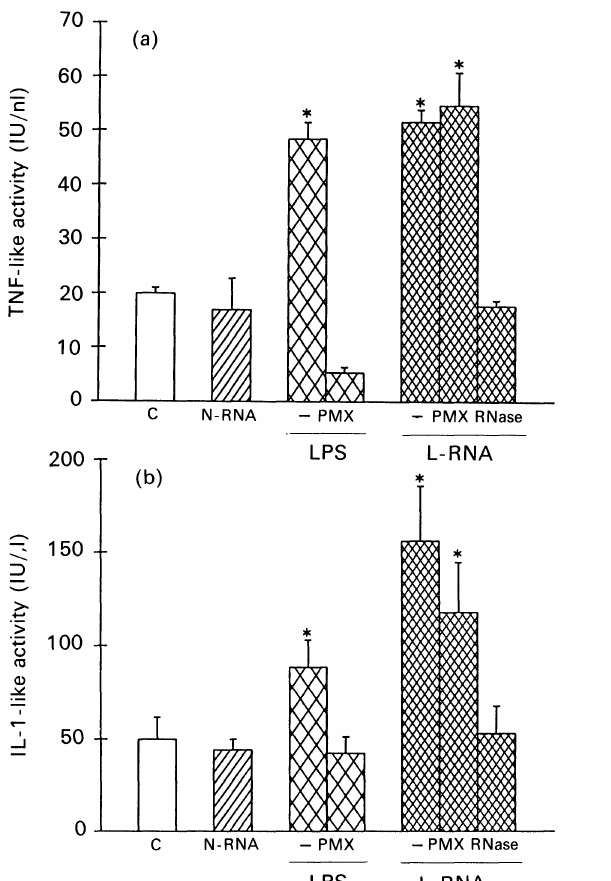
FIG. 1. The effect of L-RNA and N-RNA on the release of TNF-a and IL-1 by resident macrophages. Macrophage monolayers were incubated with N-RNA (25/l/ml), L-RNA (25/g/ml), LPS (10/g/ml) or RPMI medium alone (C) for 6 h. The L-RNA was also incubated with RNase (2/g of enzyme/10/g of L-RNA) or PMX (100#g/ml)" LPS was used as a positive control. The activity of TNF- (panel A) and IL-1 (panel B) was quantified as described in Materials and Methods. Results are given as the mean _+ S.E.M. of quadruplicates from a representative assay taken from three similar experiments. *p < 0.01 compared with control value (ANOVA; Duncan’s test).